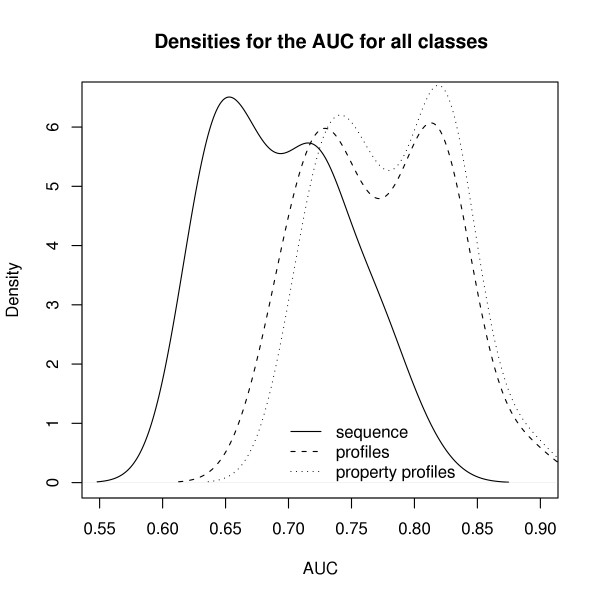
AUC densities for sequence only, amino acid profiles, and physico-chemical property profiles (RF classifier). Each of the density curves is generated from the area under the curve performance scores for each of the 27 classes.